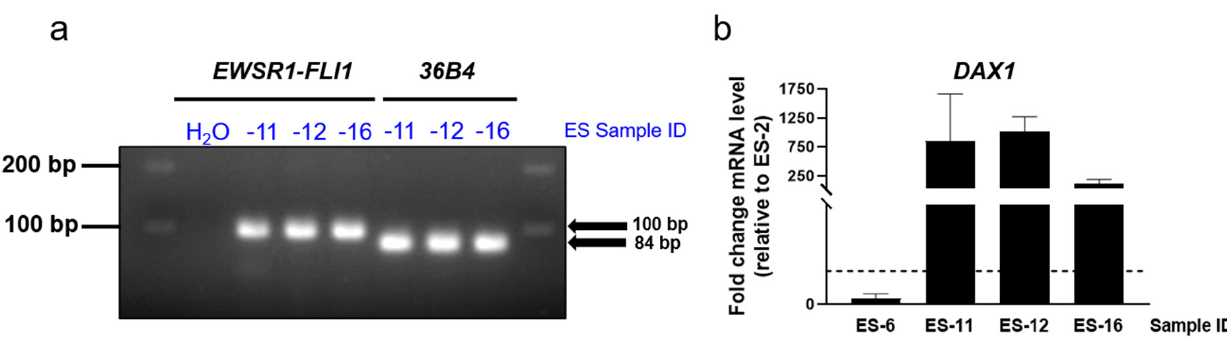
Figure 2. EWSR1-FLI1 and DAX1 mRNA expression in encapsulated ES spheroids. ( a ) DNA agarose gel showing EWSR1- FLI1 and 36B4 amplification products in encapsulated spheroids derived from three distinct ES-PDX samples. ( b ) DAX1 mRNA level in encapsulated spheroids derived from three distinct ES-PDX, shown as the fold change in mRNA level compared to ES-2, set as 1 ( n = 2).